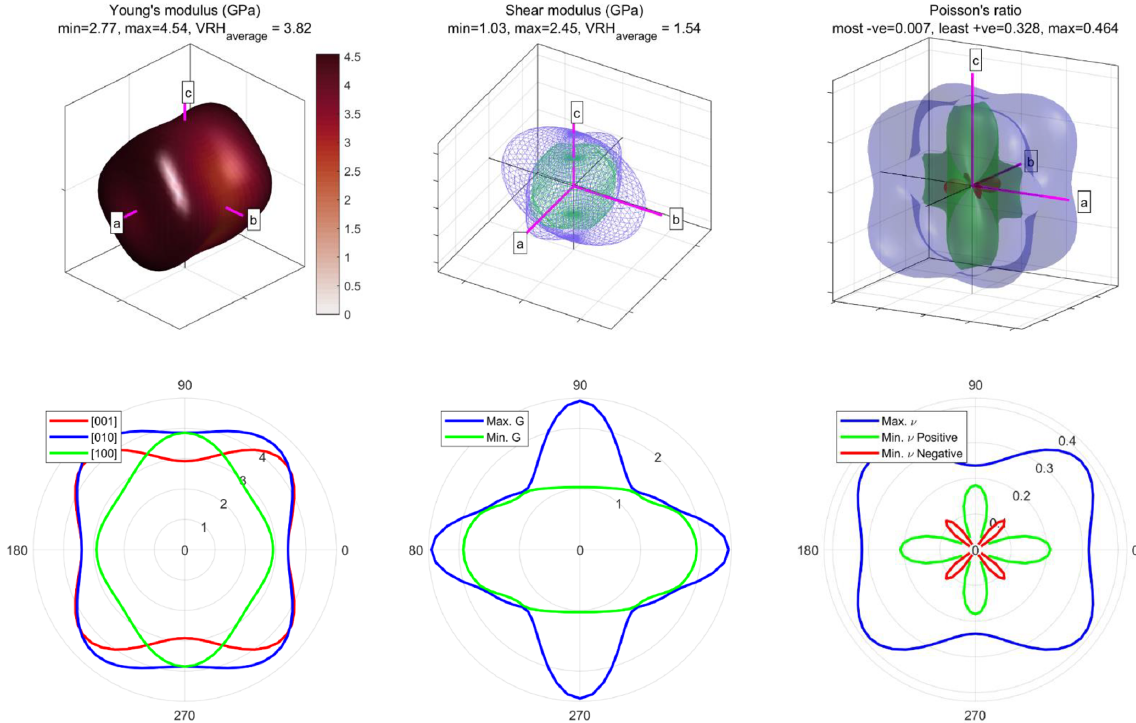
Figure A2. Benchmarks to Tan et al. (2015, their Figs. 2, 3 and 4) for orthorhombic ZIF-4, a zeolite. Plots shown for Young’s modulus, shear modulus and Poisson’s